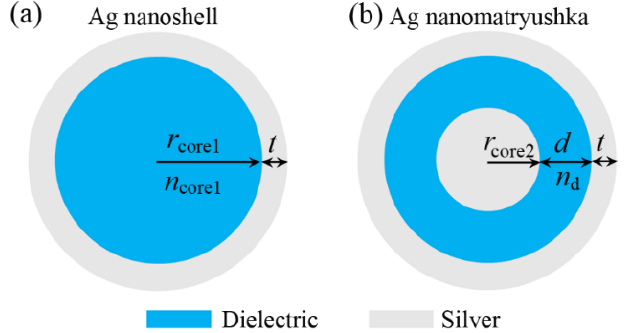
Figure 1. ( a ) Schematic of an Ag nanoshell ( a ) and a simple three-layered Ag nanomatryushka ( b ). The Ag nanoshell is formed by a silver layer (thickness: t ) coating a dielectric nanosphere (radius: r core1 ; refractive index: n core1 ), and the Ag nanomatryushka is constructed by incorporating a solid Ag nanosphere (radius: r core2 ) into the center of the same Ag nanoshell as in ( a ). The dielectric thickness and dielectric refractive index in the Ag nanomatryushka are d and n d , respectively. Due to the perfect spherical symmetry of the proposed Ag nanoshell and the Ag nanomatryushka (multilayered sphere), the extinction, scattering and absorption properties produced by the interaction between the plane wave and the proposed nanostructures can be solved analytically using an improved recursive algorithm based on Mie scattering theory [57,58]. In the analytical Mie solutions, the total extinction efficiency Q ext defined as extinction cross section divided by the cross section of the proposed nanoparticle is expressed as the following equation: